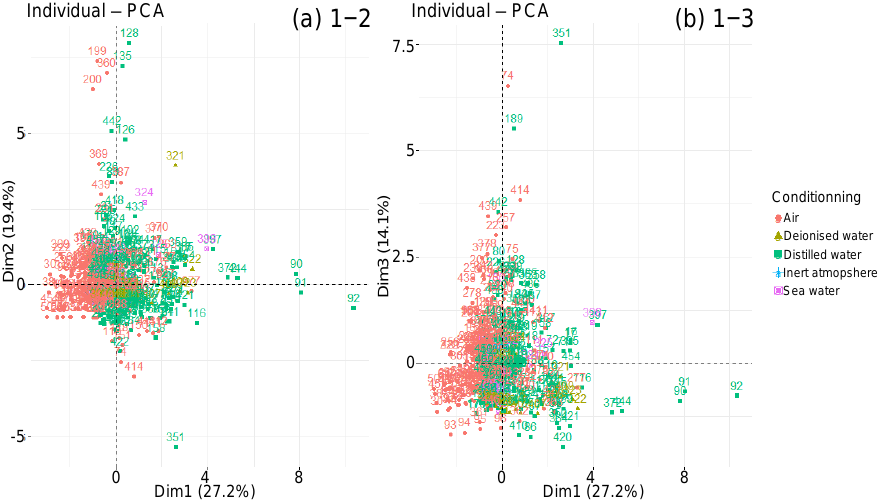
Figure 13. Graphs of individuals on planes ( a ) 1–2 and ( b ) 1–3 of the global PCA, according to conditioning